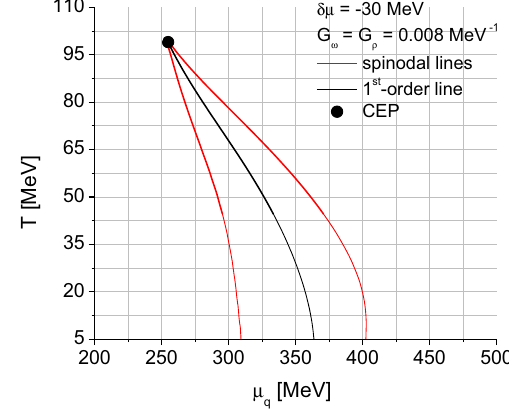
Fig. 6 First order phase transition of the QM model with δμ = − 30MeV, for G ω = G ρ = 0 . 008MeV − 1 . The red lines are the spin- odals, the black line is the first order phase transition line and the black dot is the